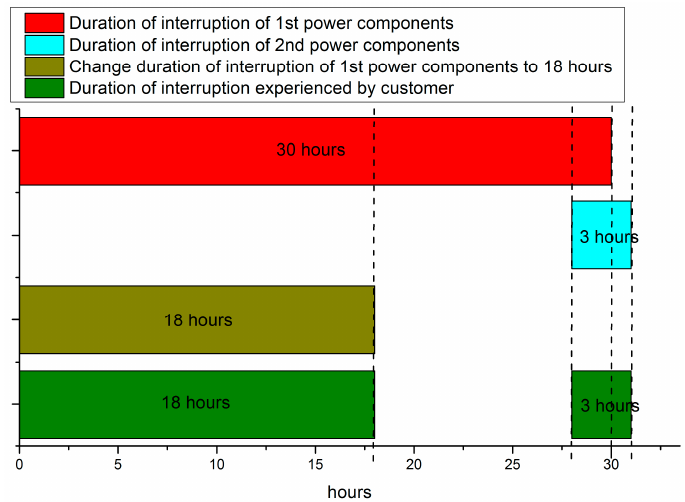
Figure 5. Example of scenario SC-2B tail graph.